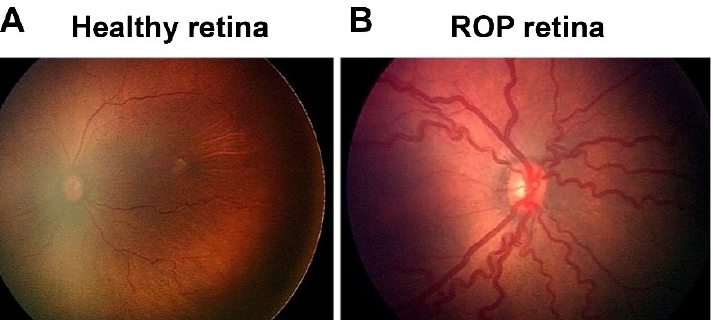
Figure 1. Fundus image of retinopathy of prematurity (ROP): ( A ) Healthy retina and ( B ) ROP retina with tortuous arteries and dilated veins as plus disease.